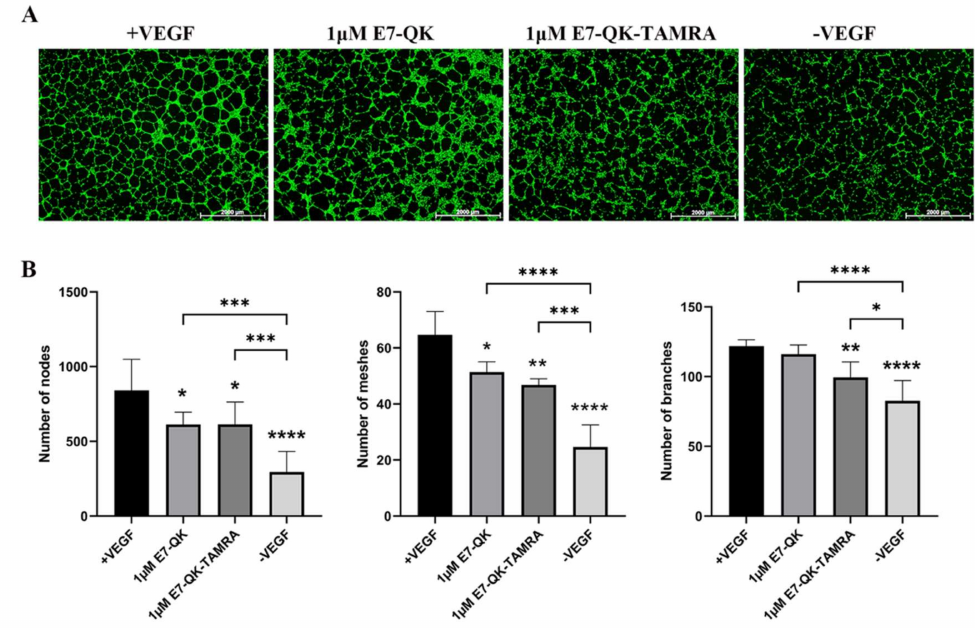
Figure 5. Tube formation by HUVECs in the presence of E7-QK-TAMRA peptide. HUVECs were seeded on Geltrex matrix in media containing 1 µ M of E7-QK, E7-QK-TAMRA peptides, VEGF (0.5 ng/mL, positive control group), or without VEGF or peptides (negative control group). ( A ) Rep- resentative images (1.25 × magnification, scale bar = 2000 µ m) of HUVEC tube formation were taken by fluorescent microscopy (Calcein AM) at 8 h after cell seeding. ( B ) Numbers of nodes, meshes, and branches were analyzed with ImageJ. Values represent means ± SD from 3 independent experiments (*, **, ***, **** without bar indicates significant differences to the +VEGF group; * p < 0.05, ** p < 0.01, *** p < 0.001, **** p < 0.0001).